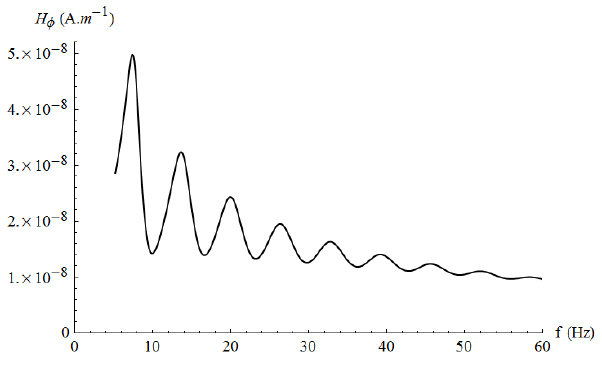
Figure 3: Current of RS-LC system with time.